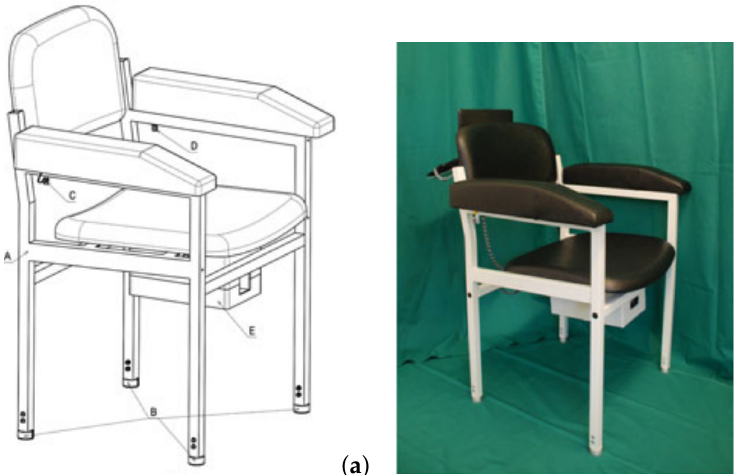
Figure 1. The aTUG chair as ( a ) conceptual design and ( b ) the prototype, used in the